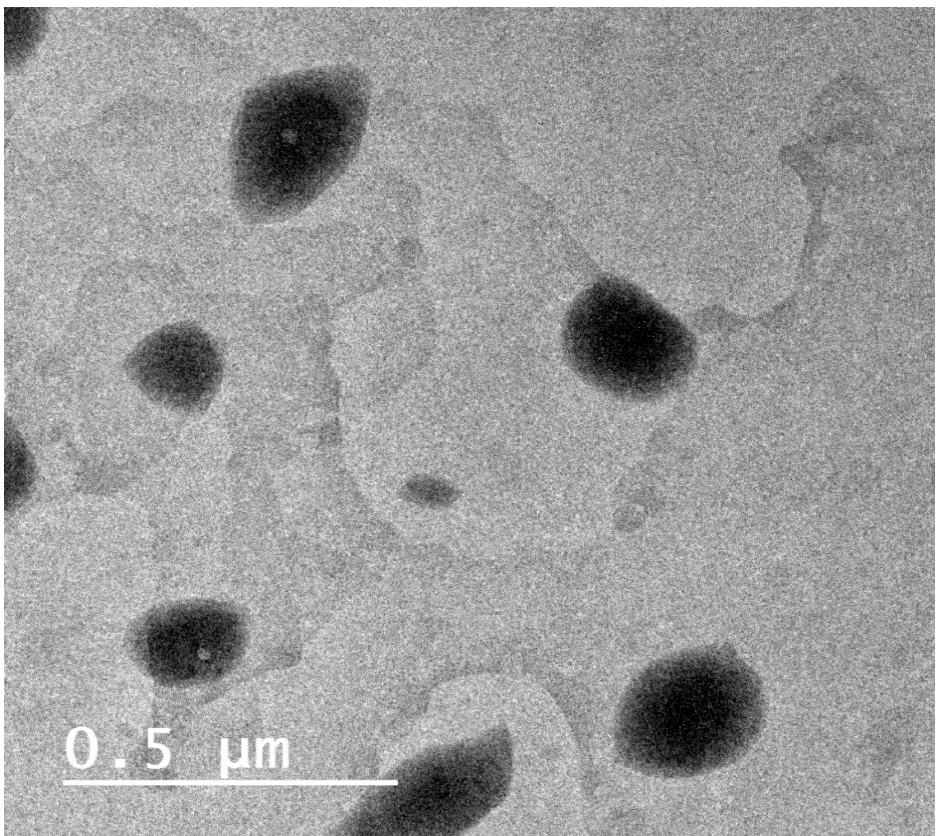
Figure 4. Transmission electron microscope image of BER-LC-CTS-NPs optimal formula.